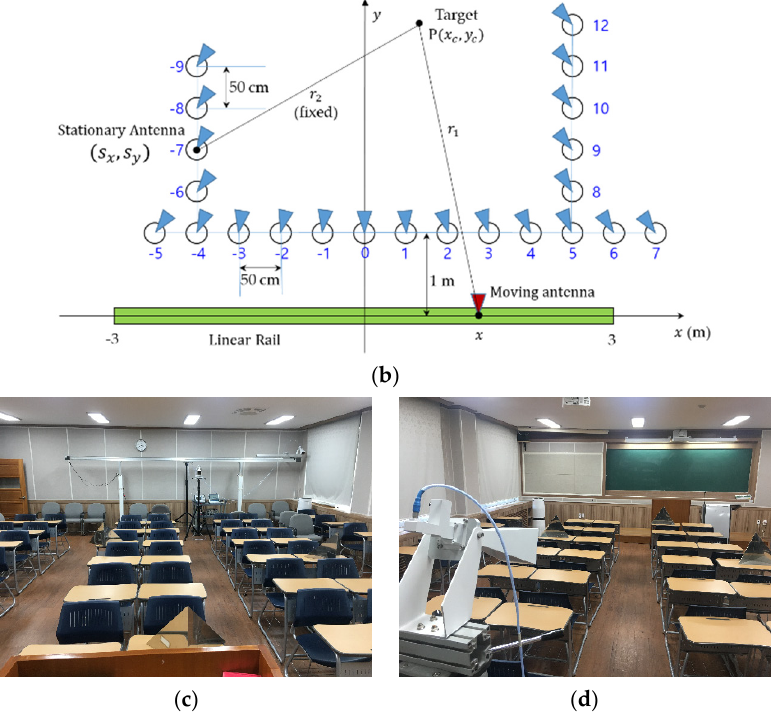
Figure 1. A ground-based synthetic aperture radar (GB-SAR) experiment with one stationary and one moving antennae inside a lecture room. ( a ) a diagram of the indoor targets and system, ( b ) a schematic geometry of the GB-SAR configuration, ( c ) a photo of the system and the targets, and ( d ) a photo of the lecture room seen from a stationary antenna with chairs and three trihedral corner reflectors. Table 1. System parameters for a bistatic/multistatic GB-SAR experiment.